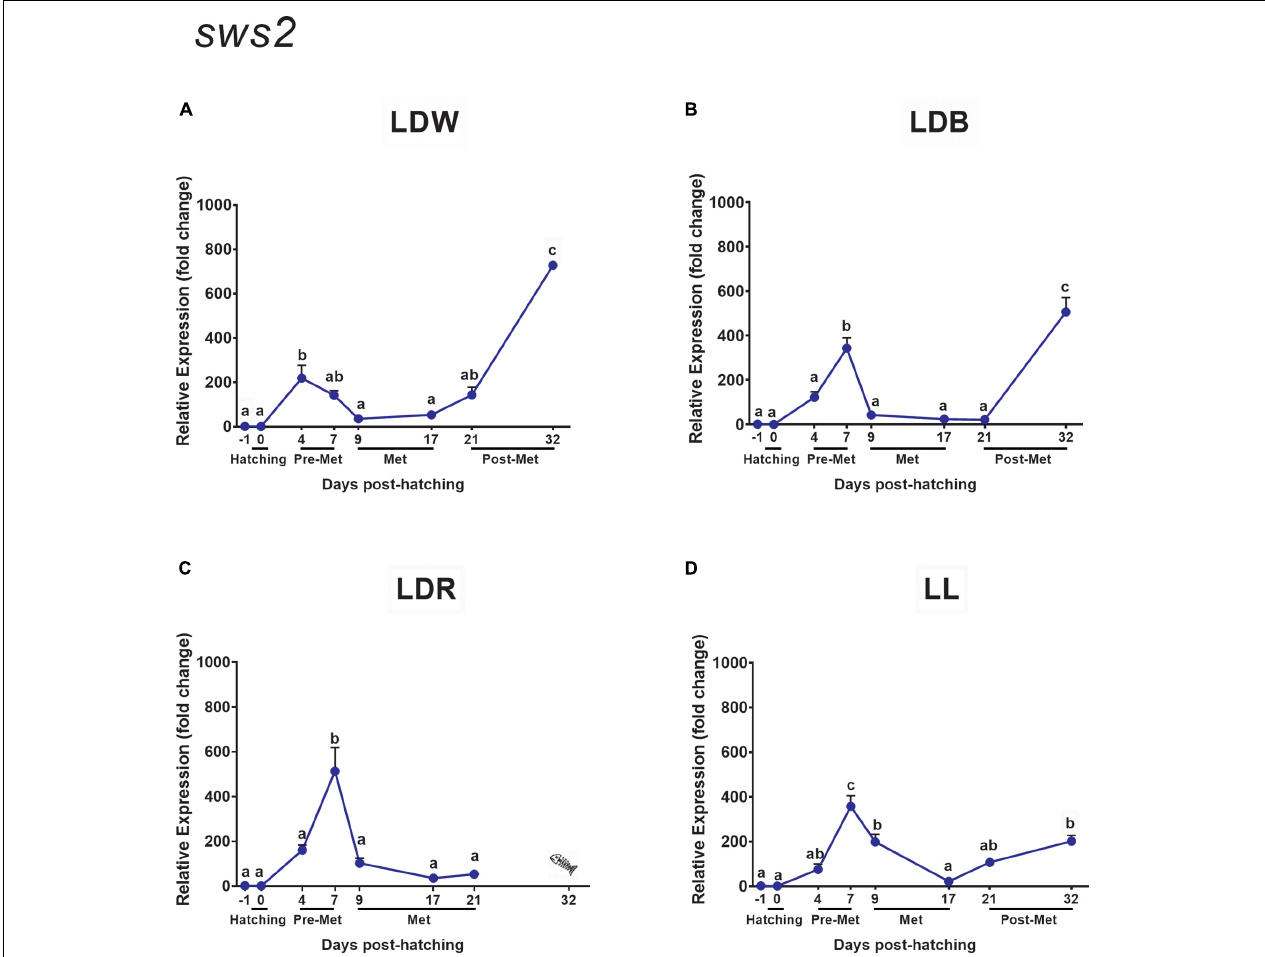
FIGURE 5 | Expression of blue cone opsin ( sws2 ) in embryos, larvae, and juveniles of the Senegalese sole on dph –1 (embryos), dph 0 (hatching), dph 4–7 (pre-metamorphosis, Pre-Met), dph 9–17 (metamorphosis, Met), and dph 21–32 (post-metamorphosis, Post-Met) analysed by RT-qPCR. For further information, see the legend in Figure 1